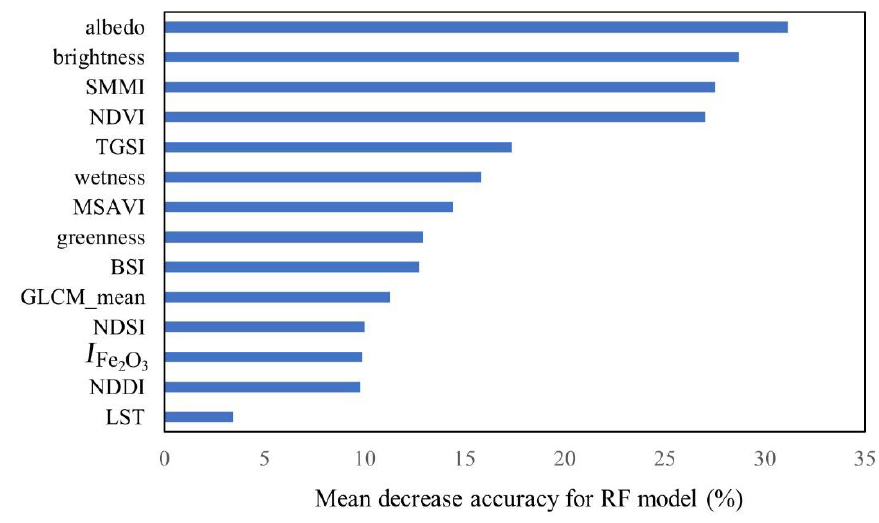
Figure A3. Selection results of the RF. RF evaluates all features by out of bag (OOB) data. If the accuracy of OOB data is greatly reduced after permuting a feature randomly, indicating that this feature has a great influence on the classification results.